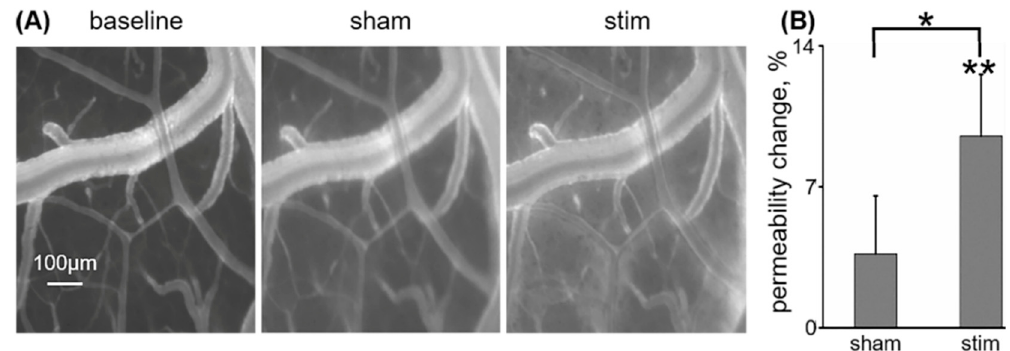
Figure 3. Low-frequency rTMS increases neocortical vascular permeability to IGF-Trap: ( A ) Fluorescent angiography of the exposed anesthetized rat cortex, following intravenous administration of succinimidyl ester-conjugated IGF-Trap (20 mg / kg), at prestimulation (baseline, left), following sham rTMS (sham, center) and following real rTMS (stim, right) at 1 Hz, 130% of resting motor threshold. Extravasation of fluorescent IGF-Trap into extravascular space, following real stimulation, is apparent. ( B ) Mean ± SEM increase in permeability index (see Section 2) from baseline, for post-sham and post-real stimulation. * p < 0.05, ** p < 0.01.